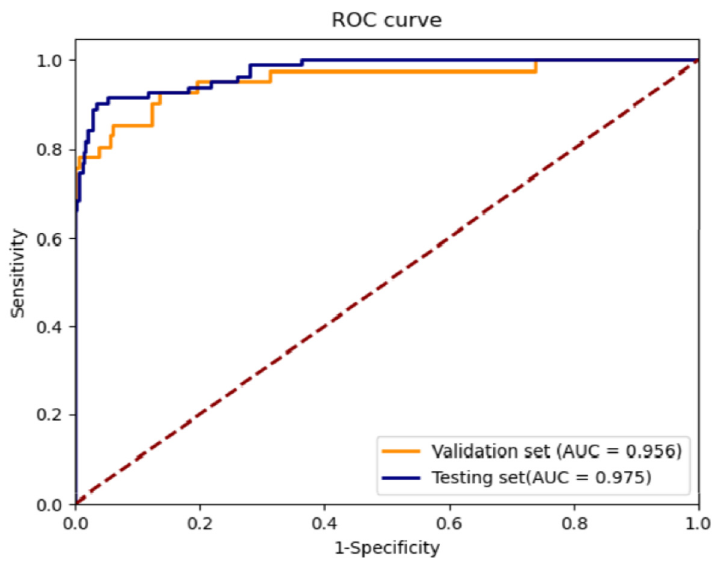
Figure 4. ROC of the screening performance on the validation set and testing set: AUC, area under the curve; ROC, receiver–operating characteristic